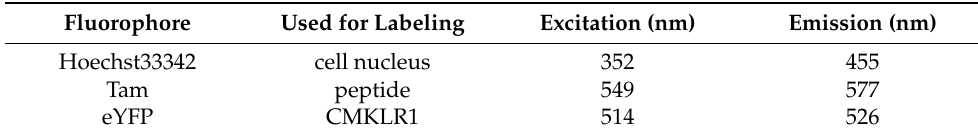
Hoechst33342: 2 (cid:48) -(4-Ethoxyphenyl)-6-(4-methyl-1-piperazinyl)-1 H ,3 (cid:48) H -2,5 (cid:48) -bisbenzimidazole; YFP: yellow fluo- rescent protein; CMKLR1: chemokine-like receptor